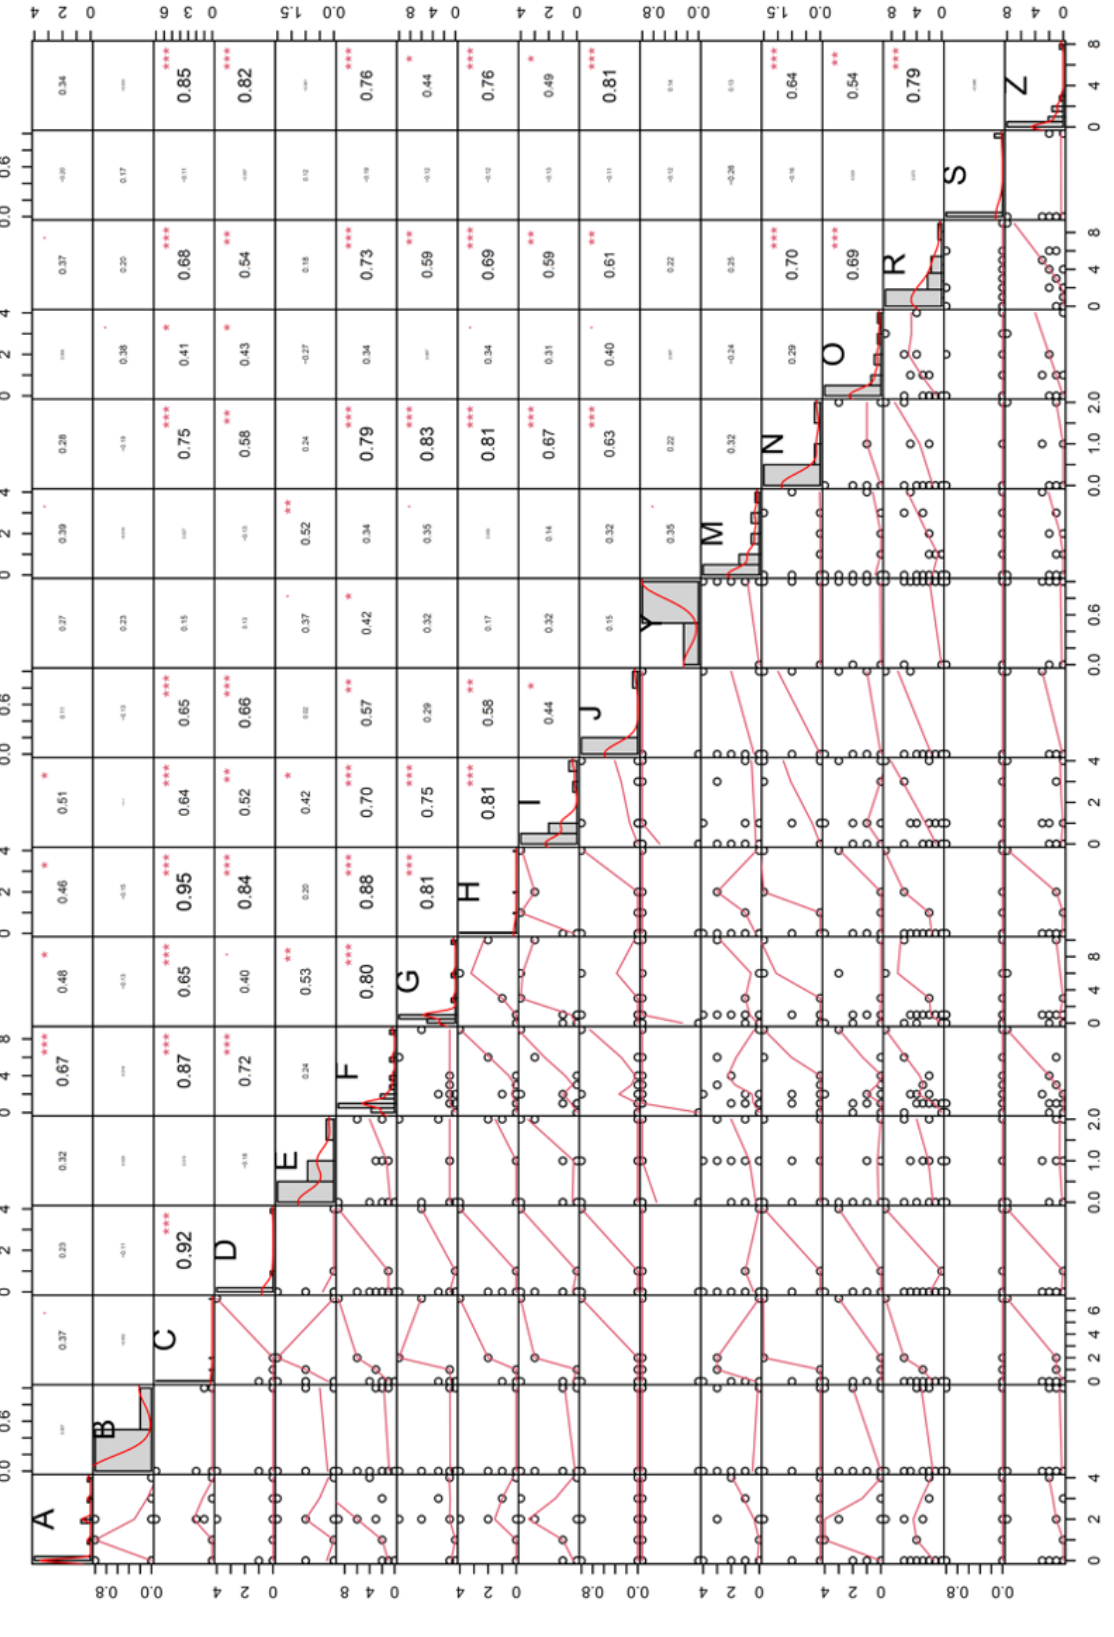
Table S2. – Results from the Pearson’s correlation analyses of recorded behaviour and body patterns of O. vulgaris facing a bait trap. A, arm exploration; B, body exploration; C, crawl; D, defence position; E, pulling the trap; F, approaching the trap; G, grabbing the trap; H, retreat; I, resting in the den; J, jet swim; Y, capture bait/prey; M, broad mottle skin; N, hood/striped skin pattern; O, passing cloud skin pattern; R, regular skin pattern; S, smooth texture; Z, dark skin pattern. (For detailed definitions see Table